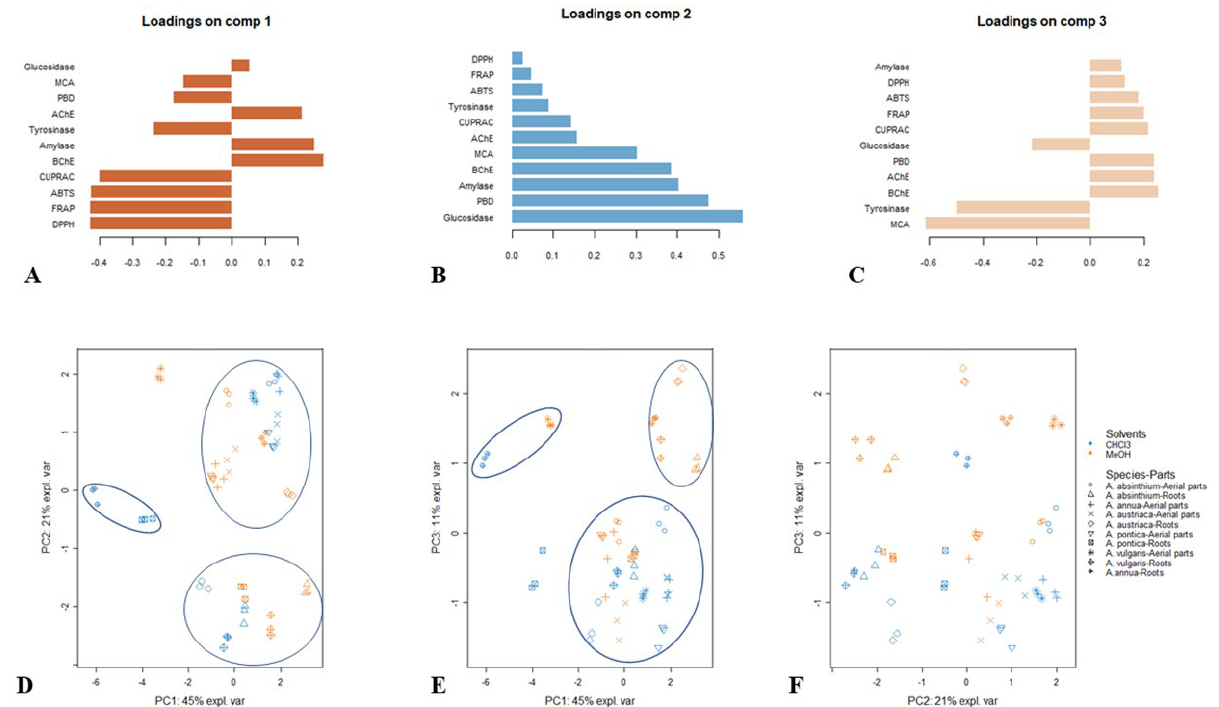
Figure 2. Exploratory principal component analysis. ( A – C ) Contribution of biological activities to the principal components of the PCA. ( D – F ) Scatter plot showing the distribution of the samples in the factorial plan derived from the three retained principal components.